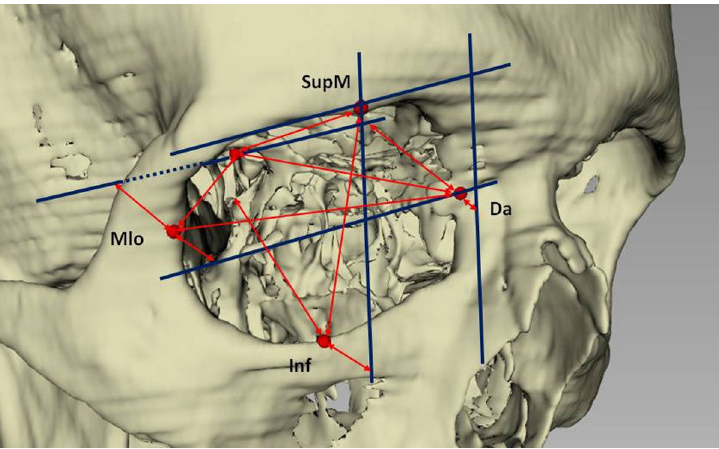
Fig 3. Visualization of anatomic parameters defining globe position measurements. An increase of the displayed distances (as stated in red arrows) anterior to the orbital aperture will lead to increased Hertel values, whereas an increase of distances within the orbit will lead to larger distances of the globe to the orbital apex. Analysis planes (parallel planes to Cor through Da , SupM , and AO are visualized as blue lines).